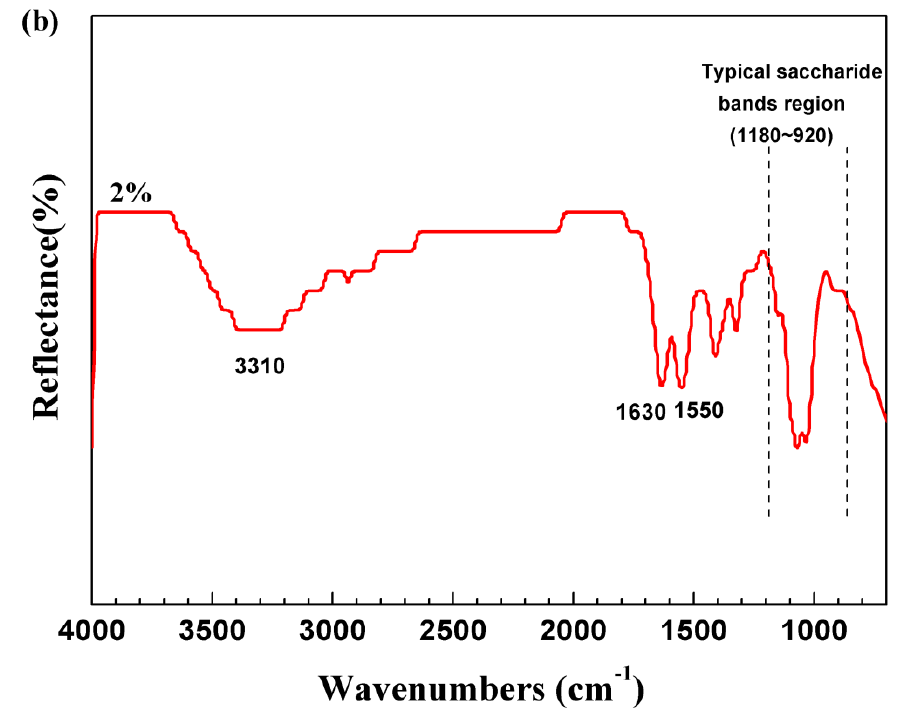
Figure 2. ( a ) FT-IR spectra for chitosan films and ( b ) ATR-FTIR spectra of the chitosan film with 2% chitosan concentration.